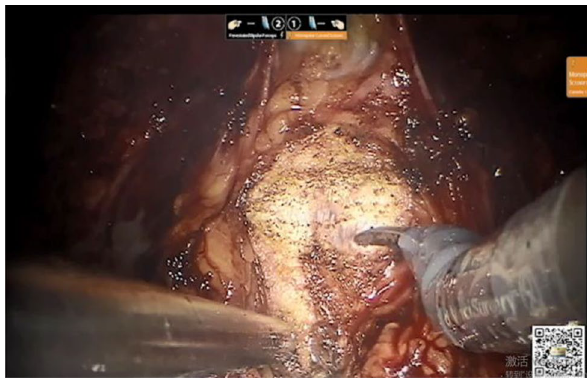
Figure 4. Amputation of the bladder